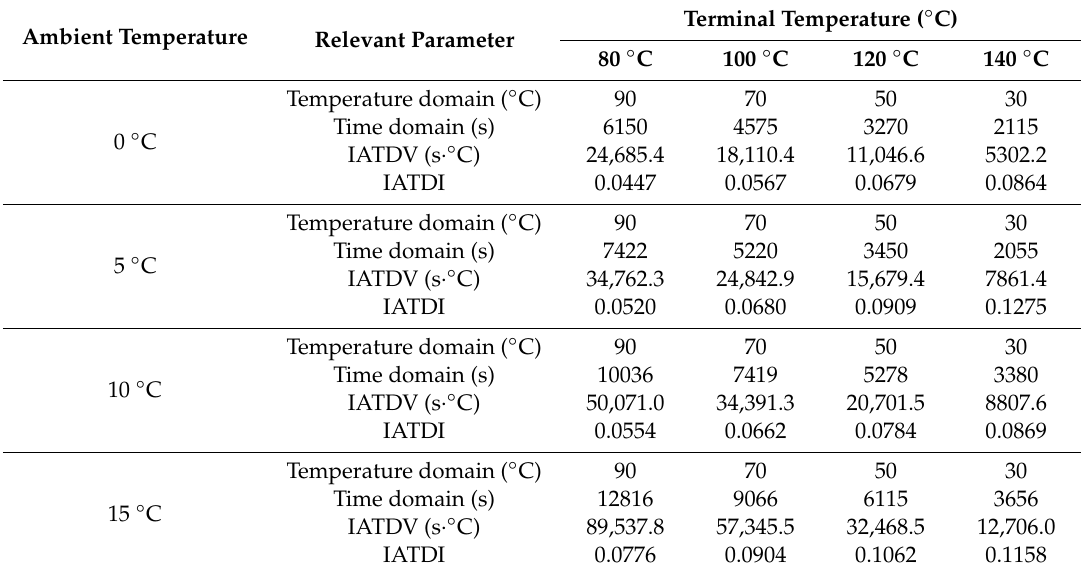
Table 4. Date of the thermal-insulation accumulated time difference value (IATDV) and thermal-insulation accumulated time di ff erence index